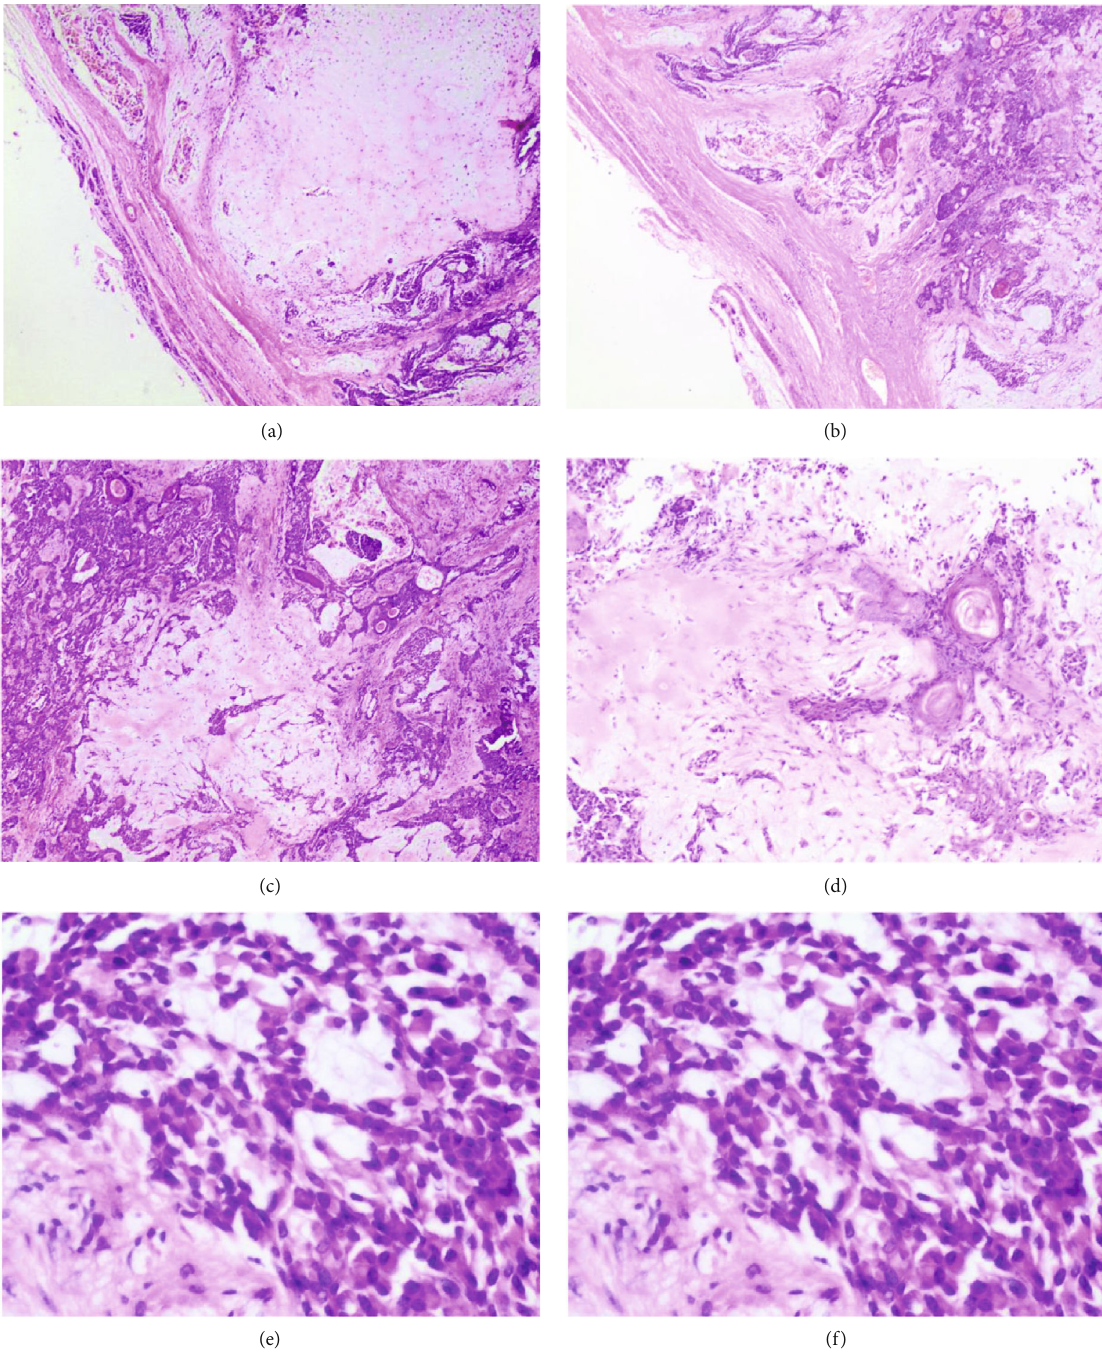
Figure 2: Pleomorphic adenoma, showing cytoarchitectural features characteristic of this tumor. Capsule and a focus of chondroid stroma ( × 100) (a) and a variegated growth pattern ( × 100) (b) are seen. Tubules containing eosinophilic material ( × 200) (c) and foci of squamous di ff erentiation ( × 200) (d) are seen. A myxoid background in which plasmacytoid hyaline cells (modi fi ed myoepithelial cells) are seen ( × 400) (e and